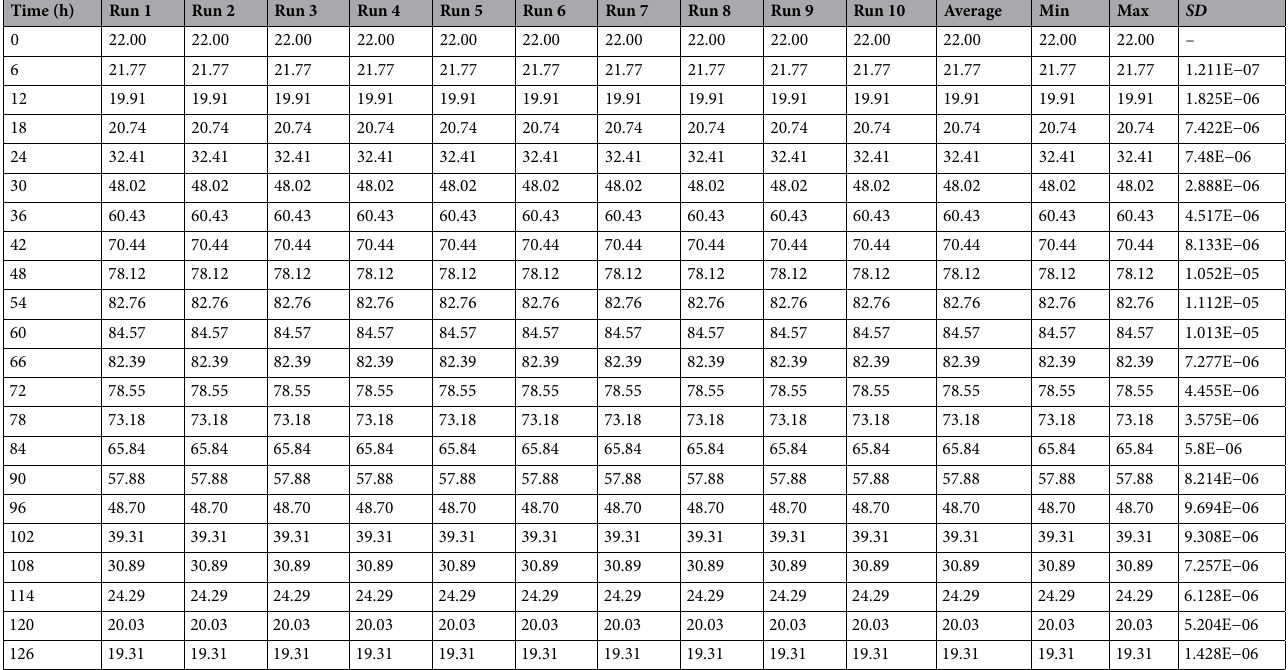
Table 1. Outflows (m 3 /s) calculated in 10 runs of “TLBO-Muskingum” for the Wilson benchmark